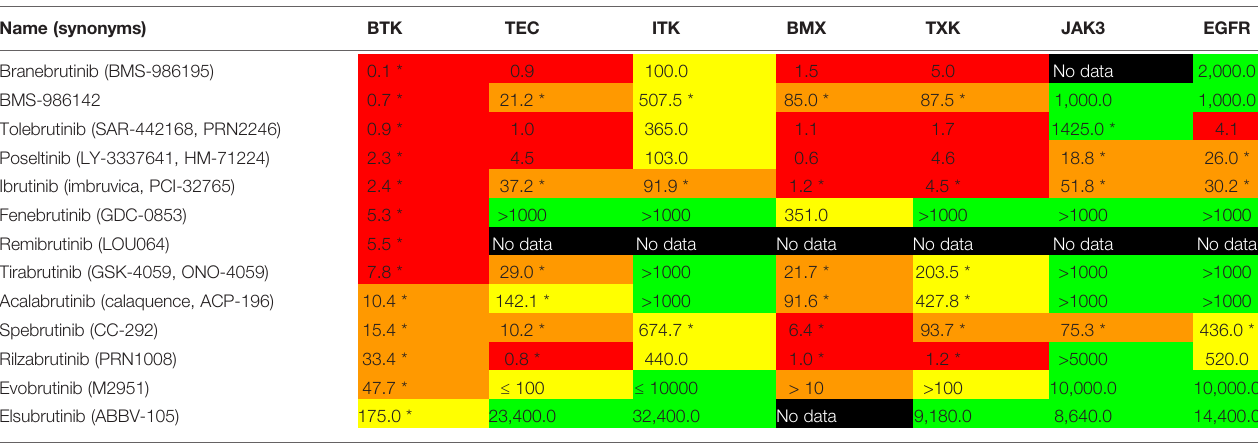
TABLE 4 | IC 50 values were collected from data provided in Cortellis Drug Discovery